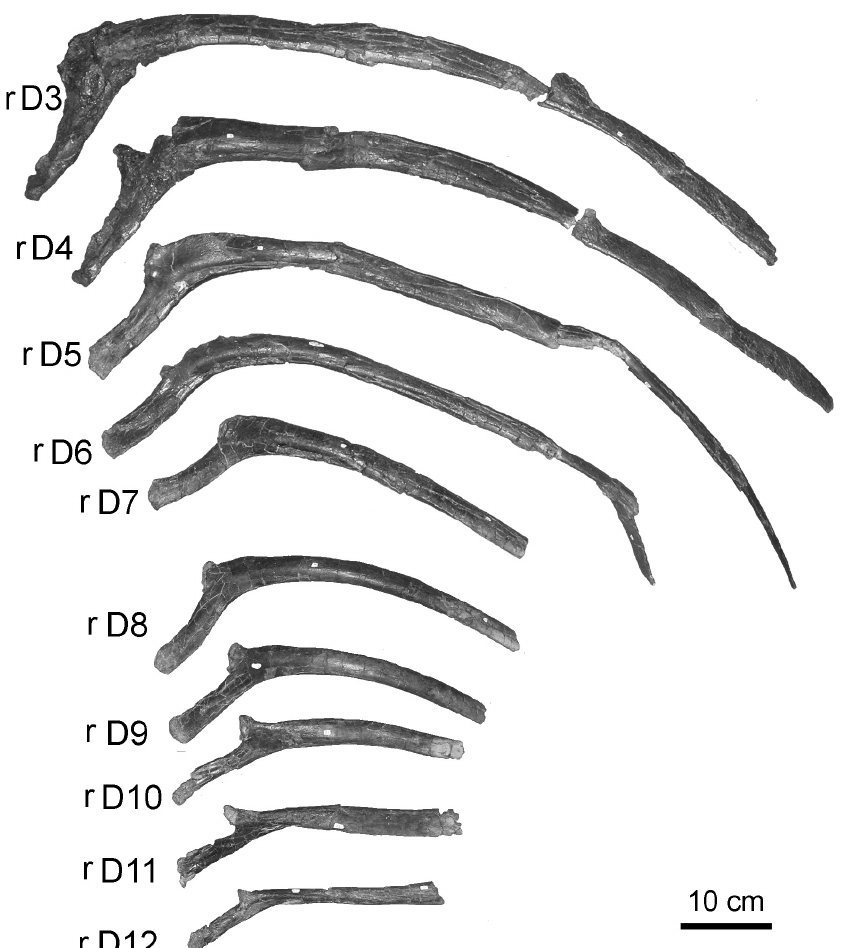
Figure 10. Ribs D3–D12, left side. Vagaceratops irvinensis , CMN